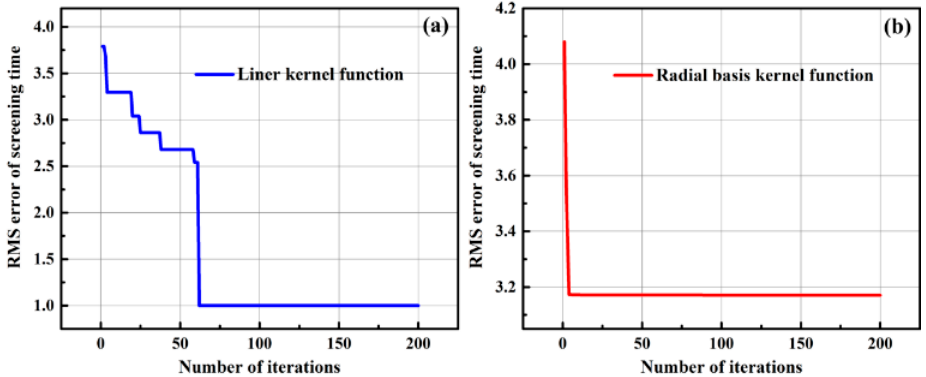
Figure 11. The iterative process for screening time under two kernel functions: ( a ) liner kernel function, and ( b ) radial basis kernel function.